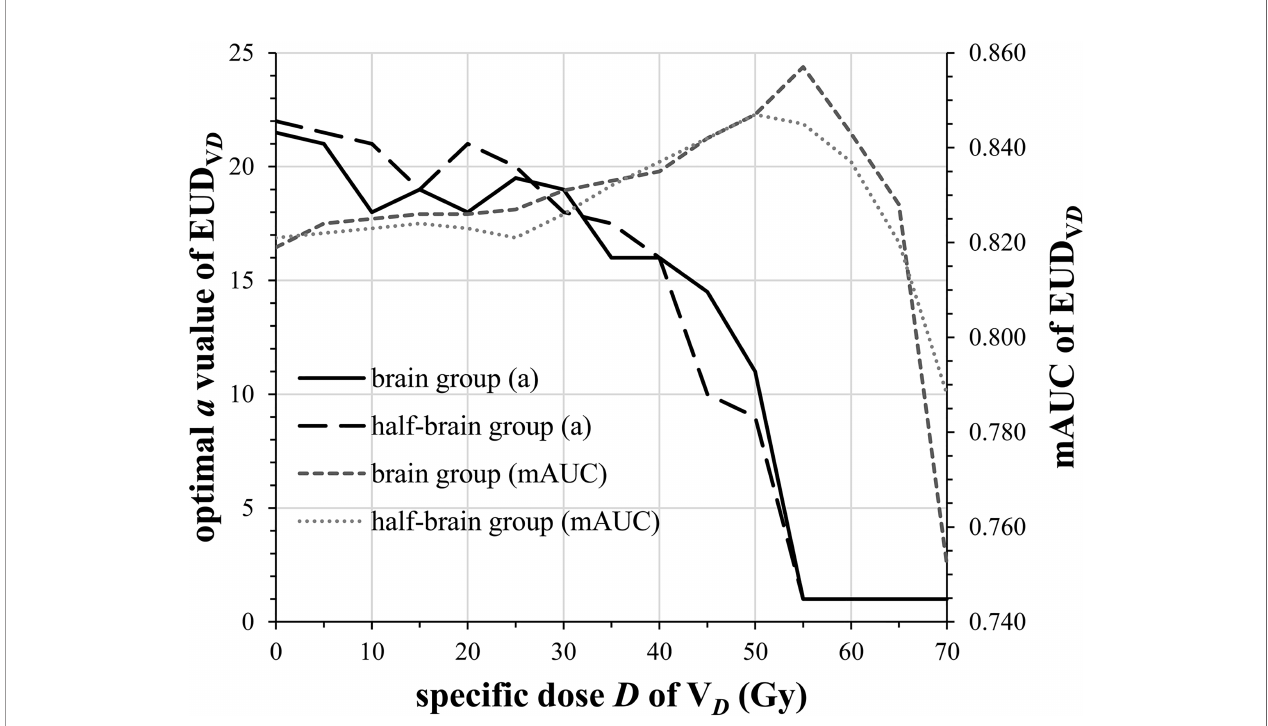
FIGURE 2 | Changes of optimal a value and mAUC of EUD V D as the speci fi c dose D changed.